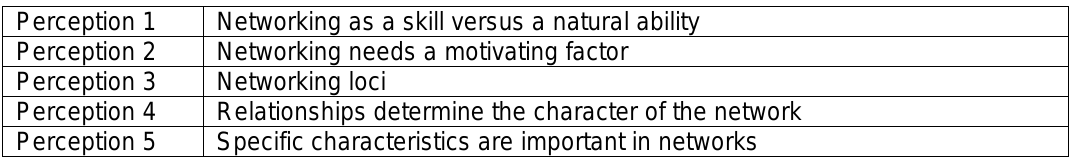
Table 3: Summary of main